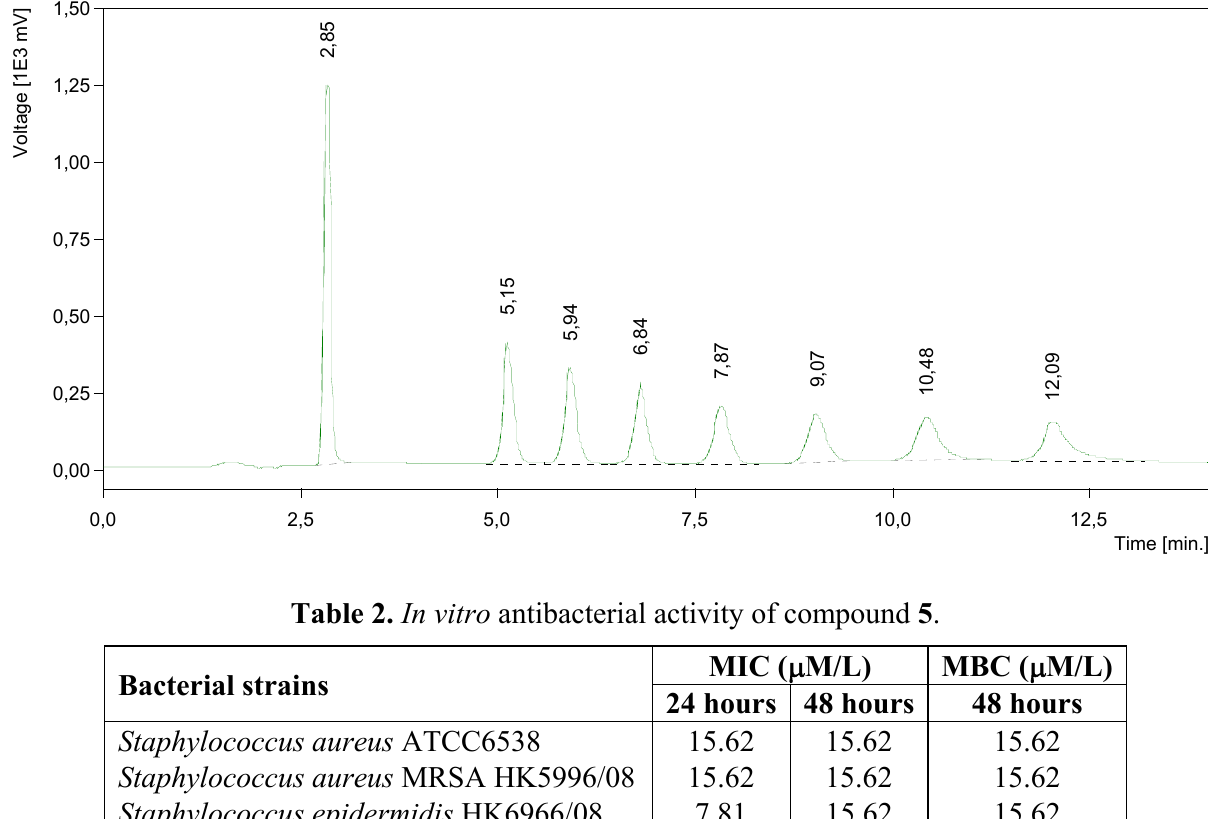
Figure 1. HPLC chromatogram of a quinolinium compound mixture.